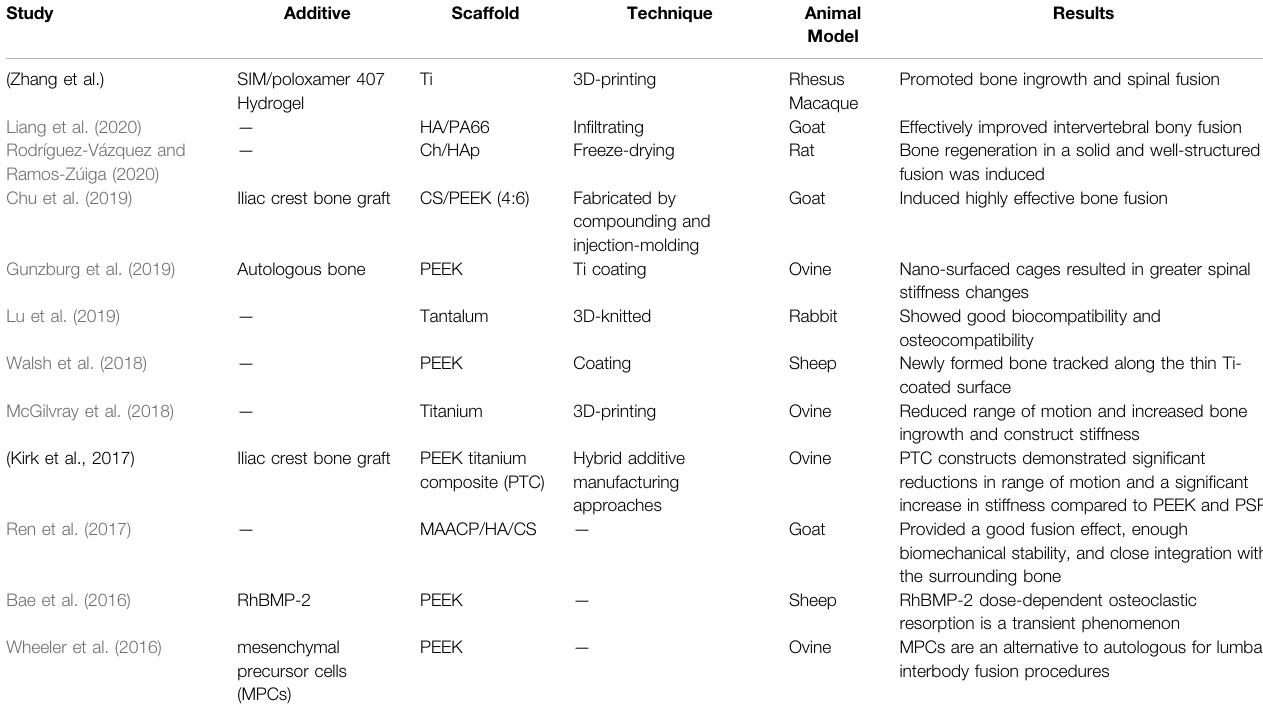
TABLE 1 | Experimental studies published